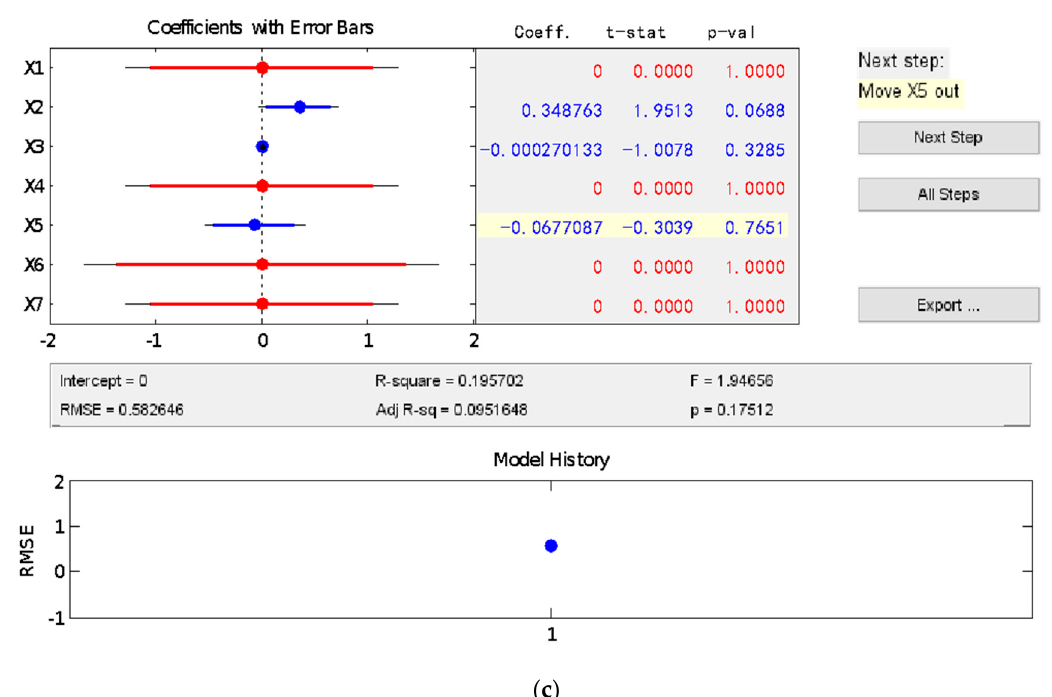
Figure 1. A multiple linear regression model constructed using the stepwise regression method. ( a ) First step, ( b ) Second step, ( c ) Third step. Table 3. The prediction results of the linear regression equation.